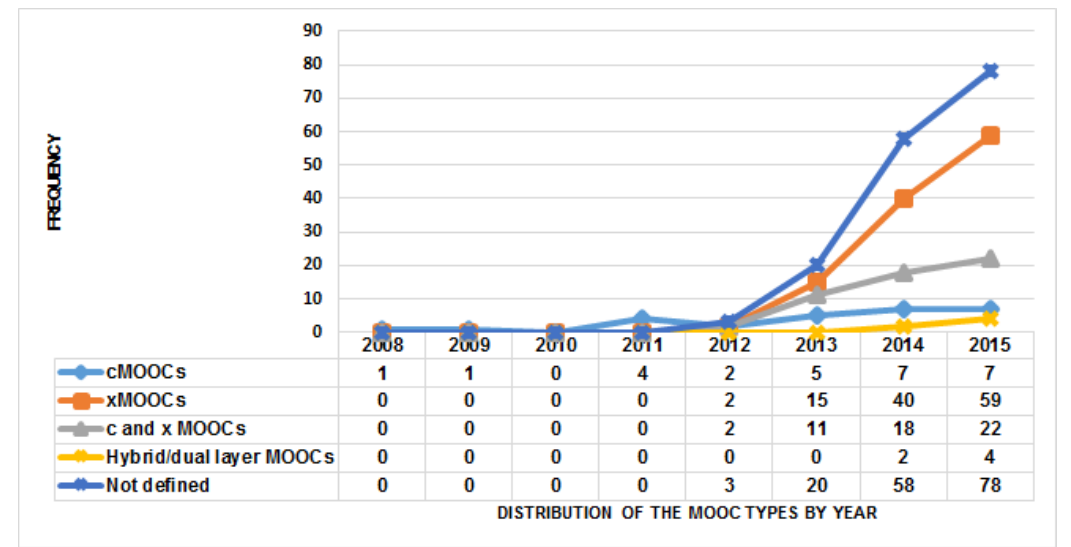
Figure 5. Distribution of MOOC types by